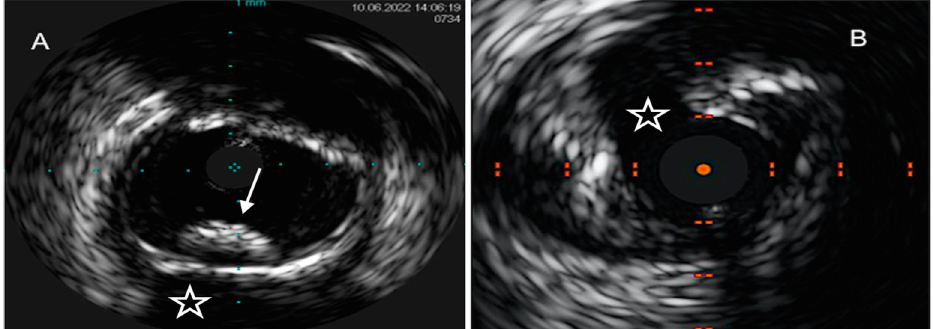
Figure 2. Examples of IVUS ‐ based mechanisms of plaque destabilization. ( A ) Example of a calcific nodule, depicted as a convex ‐ shape protrusion into the vessel lumen (5 to 7 o’clock positions) with hyperechoic appearance (( A ), white arrow) with deeper shadowing (( A ), white star). ( B ) Example of a suspected ruptured plaque in a patient with ACS, labelled as a cavity that communicates with the vessel lumen with a tear in the fibrous cap (( B ), white star).